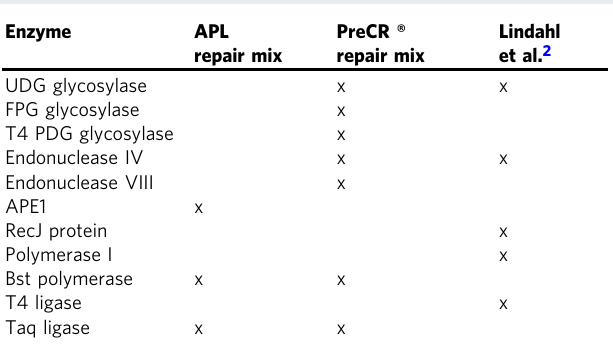
Table 1 Enzymes used and proposed in various DNA repair